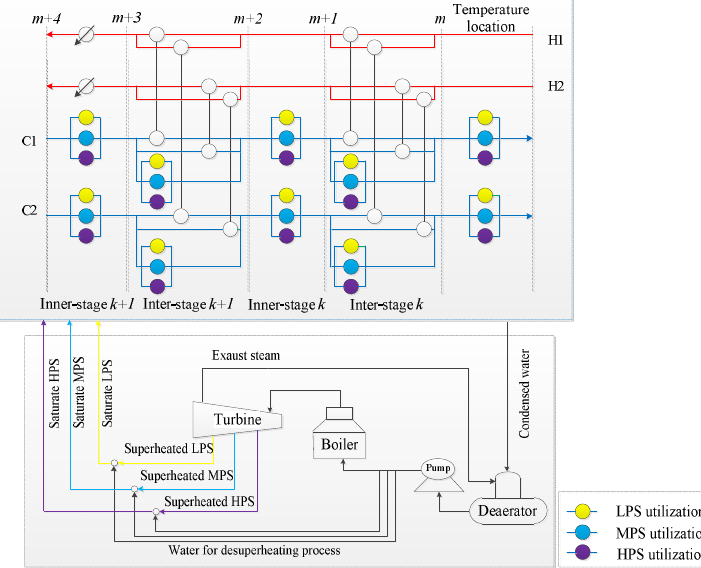
Figure 1. Superstructure for combined HEN and utility system.